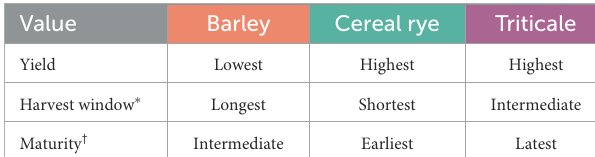
TABLE 4 Qualitative summary of the trade-offs for yield, harvest window (i.e., forage quality retention), and maturity among barley, cereal rye, and